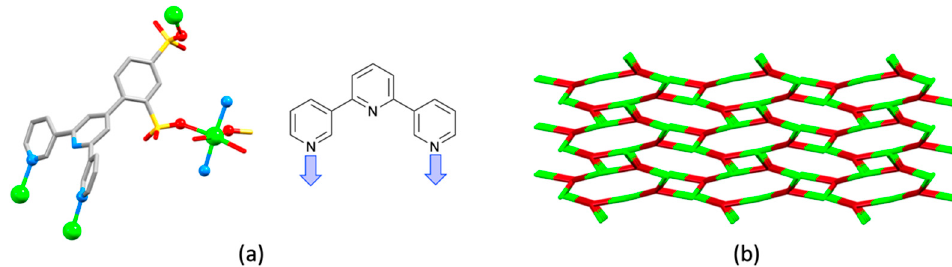
Figure 43. ( a ) The building block and representation of the conformation of the 3,2 (cid:48) :6 (cid:48) ,3 (cid:48)(cid:48) -tpy unit in [Zn( 65 )(OH 2 ) 2 ] n · 2 n H 2 O Figure 43. (a) The building block and representation of the conformation of the 3,2’:6’,3” ‐ tpy unit in [Zn( 65 )(OH 2 ) 2 ] n . 2 n H 2 O (CSD refcode DUWDUW), and (b) part of the 3D sar network in (CSD refcode DUWDUW), and ( b ) part of the 3D sar network in [Zn( 65 )(OH 2 ) 2 ] n · 2 n H 2 O with 4-connecting Zn nodes (green) [Zn( 65 )(OH 2 ) 2 ] n . 2 n H 2 O with 4 ‐ connecting Zn nodes (green) and 4 ‐ connecting ligand nodes (red); and 4-connecting ligand nodes (red); the ligand node is defined as the centroid of the central pyridine the ligand node is defined as the centroid of the central pyridine ring.